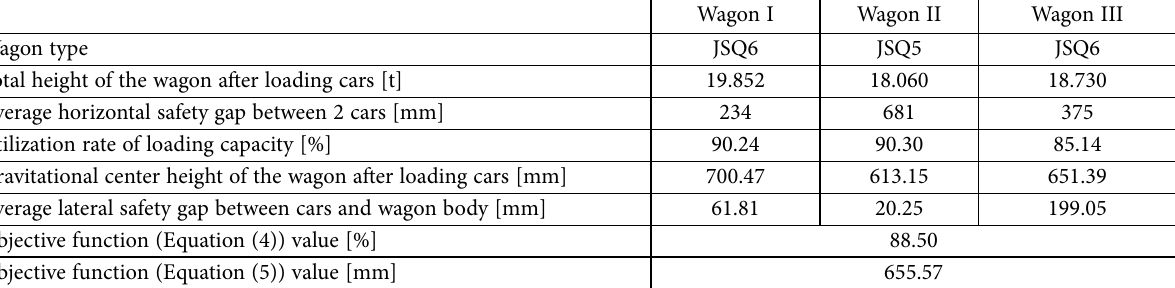
Table 5. Statistics information about the wagons and loaded cars